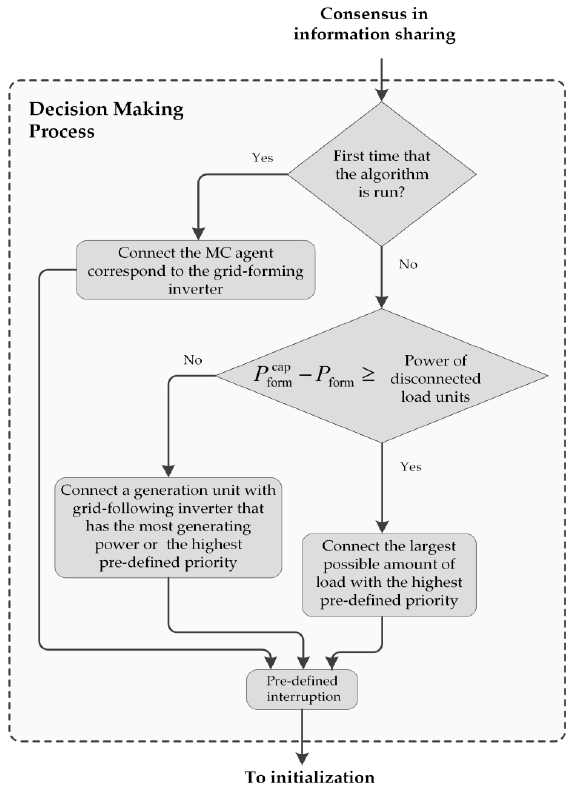
Figure 9. Flowchart of the decision making process.